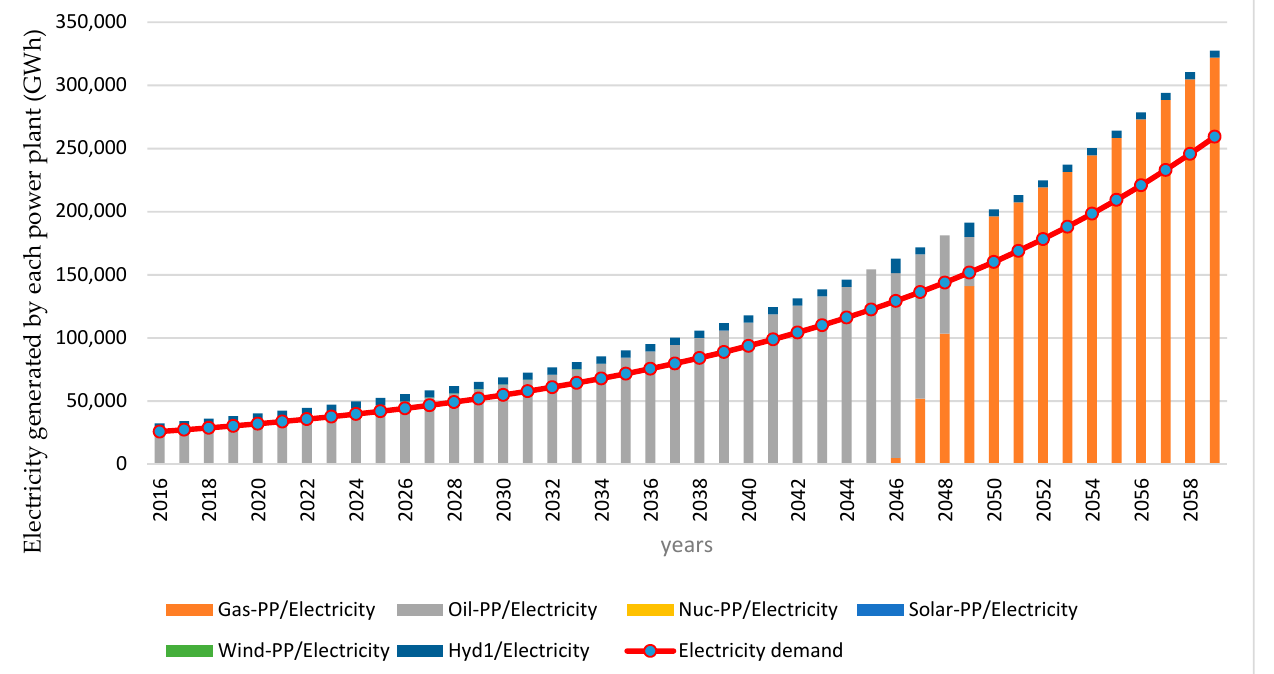
Figure 5. Environmental impacts and damage costs of the Egbin fossil power plant (FPP) in Nigeria. ( a ) SIMPACT results showing the number of cases per year affected by pollution from Egbin FPP. ( b ) SIMPACT results showing damage cost resulting from pollution generated by Egbin FPP.